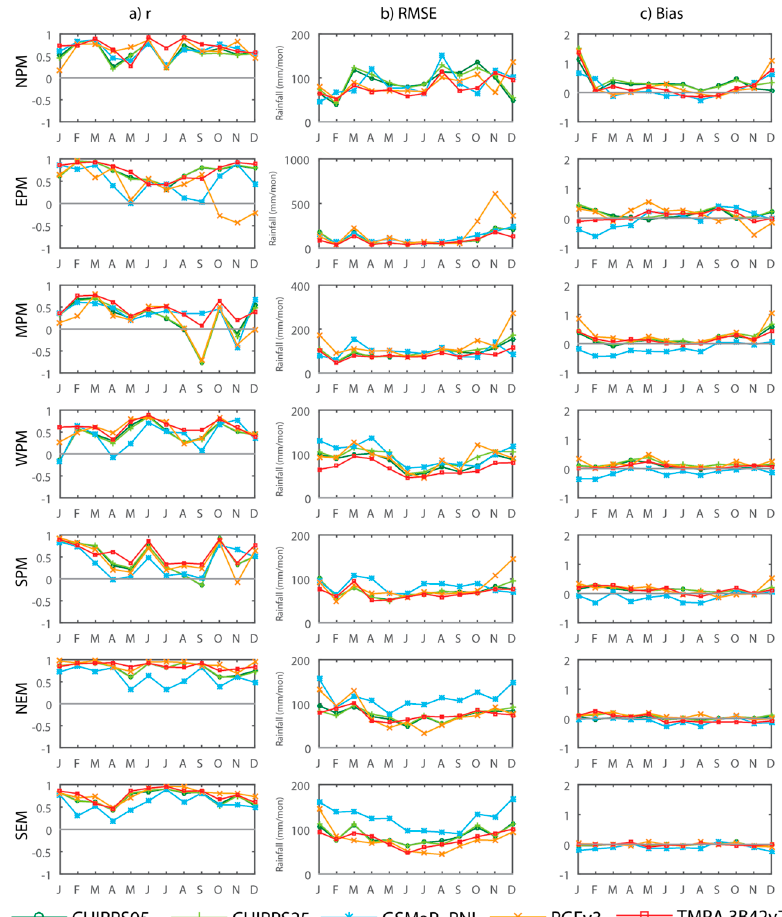
Figure 3. Values of statistical measures of CHIRPS05, CHIRPS25, GSMaP_RNL, PGFv3 and TMPA 3B42v7: ( a ) Pearson Correlation Coefficient, r, ( b ) Root Mean Squared Error, RMSE, ( c ) Bias, B for each month for seven sub ‐ regions in Malaysia.